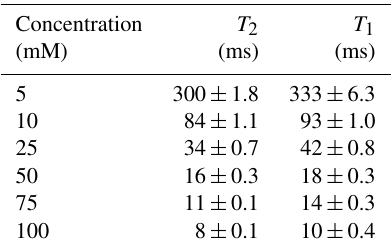
Table 3. Relaxation times of different concentrations of copper sul- fate